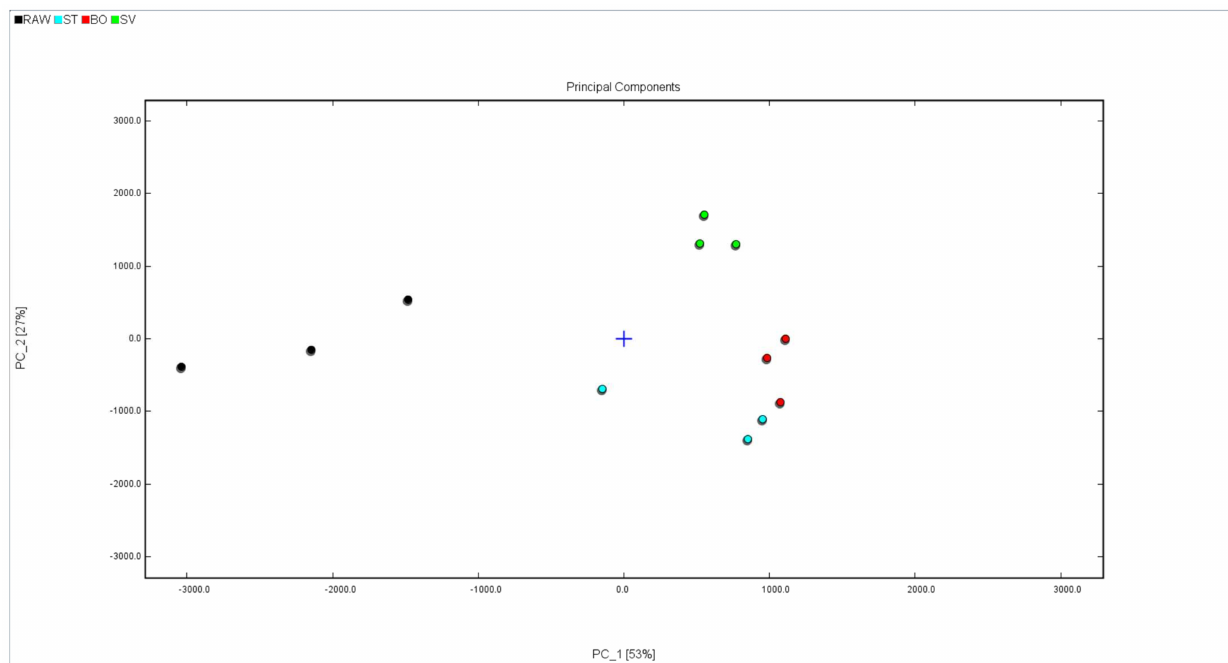
Figure 9. PCA analysis of volatile compounds in squid ( Symplectoteuthis oualaniensis ) mantle muscle from different cooking methods. RAW: raw squid; ST: steaming; BO: boiling; SV: sous